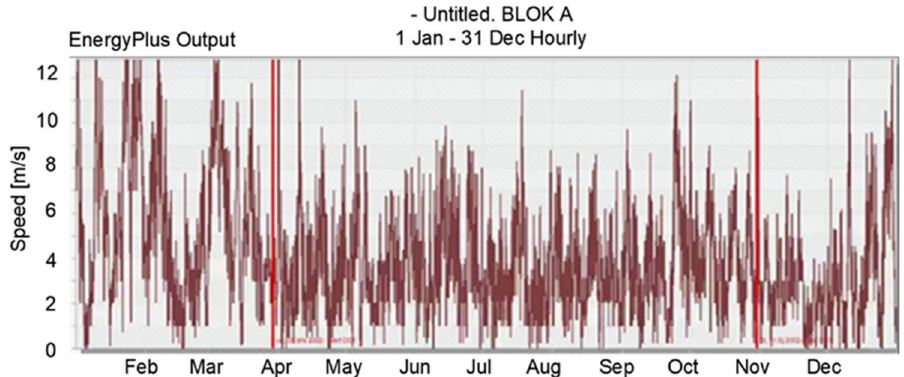
Figure 10. Wind speed in the solved locality throughout the year.